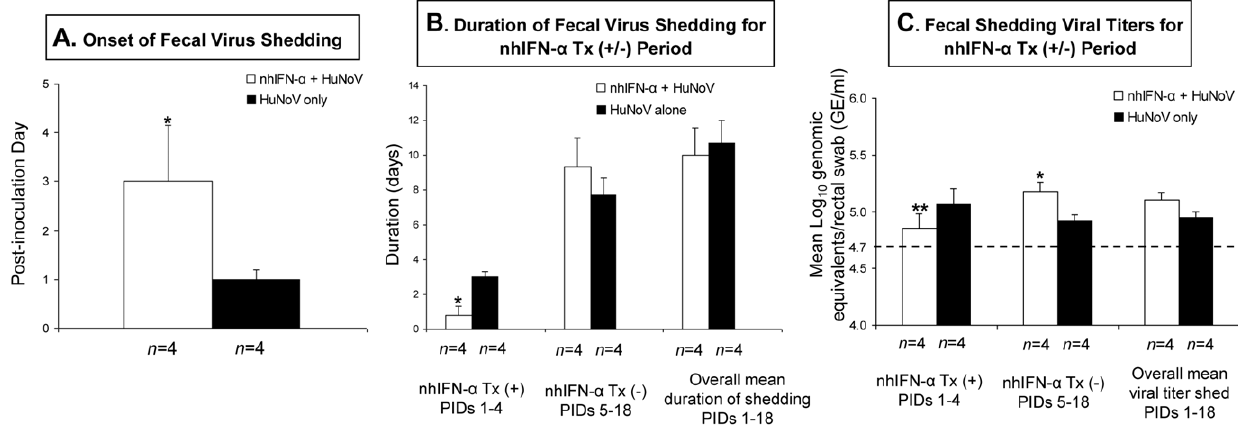
Figure 7. HuNoV fecal shedding in infected pigs can be reduced or curtailed during oral treatment with natural human IFN- a . The mean onset and duration of fecal HuNoV shedding are summarized ( A, B ), and the daily viral titers (mean) as monitored by qRT-PCR are shown ( C ). Five or six day-old piglets were treated orally with 300 IU of nhIFN- a once a day from PID -1 to PID 4. On day 2 after nhIFN- a treatment, they were inoculated orally with GII.4 HS194 HuNoV, and subsequently treated with nhIFN- a (300 IU) for 5 more days. After nhIFN- a treatment or HuNoV inoculation, clinical signs and fecal virus shedding were monitored daily until shedding terminated. Data from 2 independent animal trials were combined, and the PCR test was performed in duplicate or triplicate. Duration of virus shedding in nhIFN- a -treated and untreated pigs were analyzed based on nhIFN- a treatment period, i.e. during treatment at PIDs 1–4; post-treatment at PIDs 5–18; and overall at PIDs 1–18. Each bar represents the mean 6 SEM. * P , 0.05; ** P , 0.01 for nhIFN- a + HuNoV vs HuNoV alone by the unpaired two-tailed Mann-Whitney test. Animal numbers ( n ) are indicated at the bottom of each graph. The dotted line indicates the detection limit (4.7 log 10 GE/ml) of the qRT-PCR.